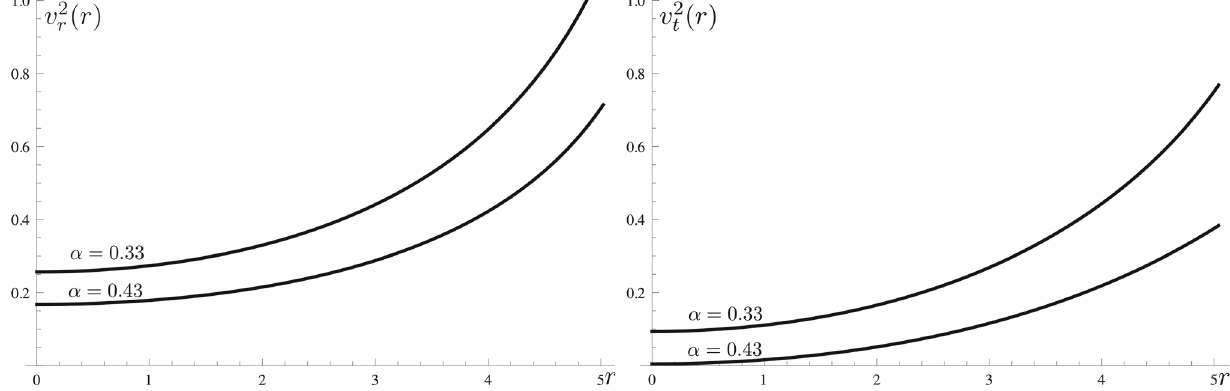
Fig. 2 Effective density ˜ ρ( r ) [10 − 3 ] and anisotropy (cid:11)(α, r ) [10 − 4 ] for a stellar system with compactness M / R = 0 . 2. Radial coordinates are in units of M ( r = 5 = R ) . The cosmological constant (cid:5) ∼ 10 − 52 is too small to be relevant